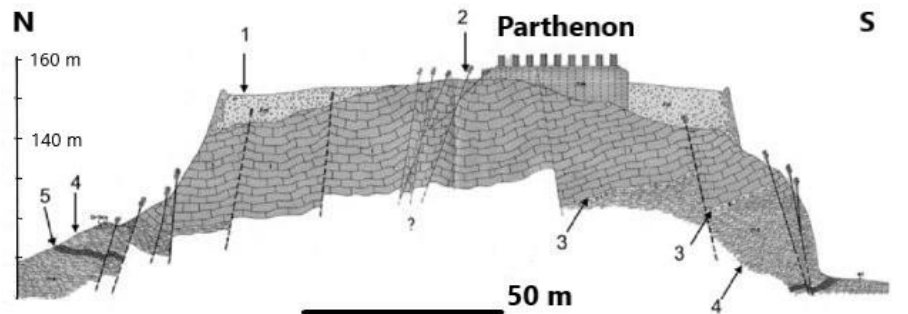
Figure 6. Geological section of the Acropolis hill, passing near the Klepsydra spring in the North, after Andronopoulos and Koukis [41], simplified; 1 : artificial earth fill, 2 : Upper Cretaceous limestones, 3 : conglomerate, 4 : the upper marly unit of the formation of the Athenian Schists composed of sandstones, limestones and marls, 5 : limestones interbedded in the marly unit, ? : no data.